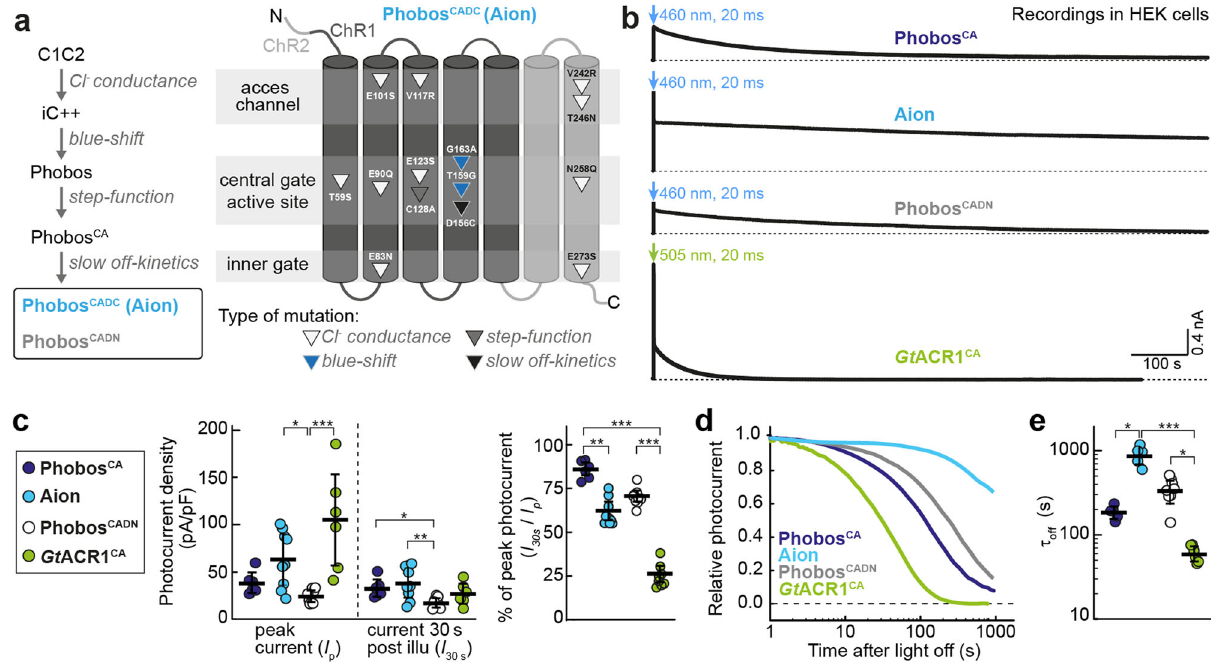
Fig. 1 Development of Aion and Phobos CADN and photocurrent characterization in HEK cells. a Engineering strategy yielding Aion and Phobos CADN , two new blue-shifted, step-function ACRs with temporally extended conducting states. Mutation of the D156 residue to either C or N (yielding Aion and Phobos CADN , respectively) greatly slows down the closing kinetics of the ACRs compared to their parental construct Phobos CA . The generated variants are highlighted by a black frame. The schematic drawing of Aion indicates point mutations (triangles) at the relative positions within the respective transmembrane helices. b Representative photocurrent traces of the slow-cycling ACRs Phobos CA , Aion, Phobos CADN , and Gt ACR1 CA activated by a short 20 ms light pulse at indicated wavelengths and irradiance of 3.35 mW/mm 2 (460 nm) and 3.14 mW/mm 2 (505 nm). c Quanti fi cation of peak photocurrent ( I p ) and photocurrent 30 s post illumination ( I 30s ) for each ACR. The resulting photocurrent ratio at 30 s compared to the peak is plotted as percent of peak photocurrent. d Normalized photocurrent after light shutoff. e Closing time constants ( τ off ) for each ACR. For c and e , black lines correspond to mean values ± SEM, and circles are single measurement data points ( n PhobosCA = 6 cells ( c ), 5 cells ( e ), n Aion = 9 cells ( c left), 10 cells ( c right), 5 cells ( e ), n PhobosCADN = 9 cells ( c left), 11 cells ( c right), 8 cells ( e ) n Gt ACR1CA = 6 cells ( c left, e ), 8 cells ( c right)). Kruskal – Wallis test with Dunn ’ s multiple comparisons test, * p < 0.05, ** p < 0.01, *** p <